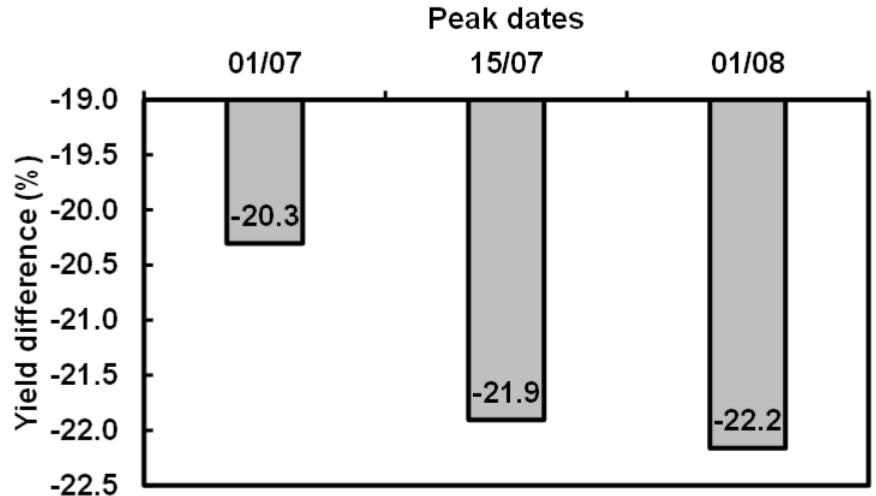
Figure 6. Average relative yield differences (%) for all the regions at each peak date.